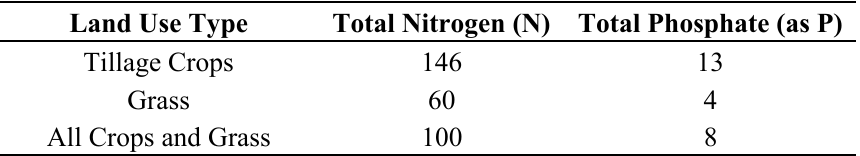
Table 2. Average overall nitrogen and phosphate fertiliser use in the UK between 2010 and 2011 (kg ha − 1 yr − 1 )